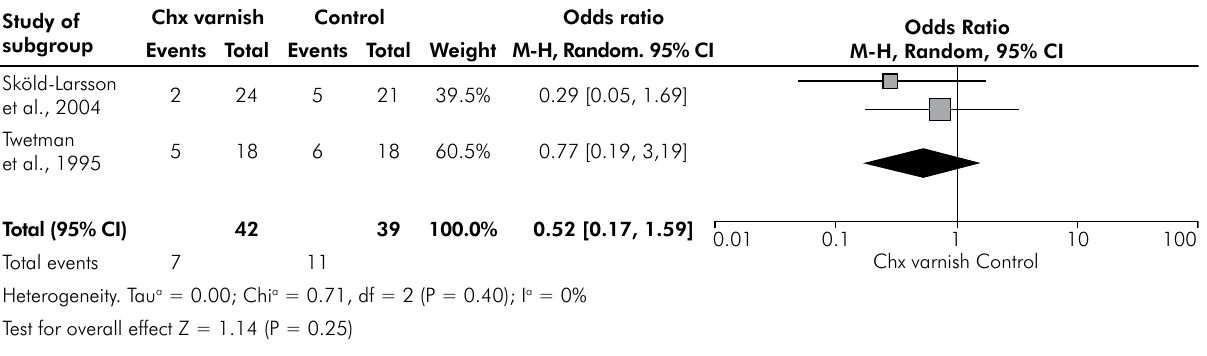
Figure 3. Forest plots of the included studies in the dichotomous data analysis.